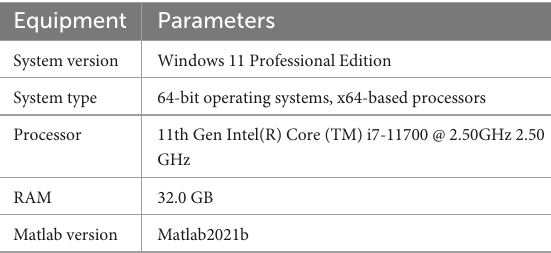
TABLE 2 The parameters of the algorithms involved in this article.